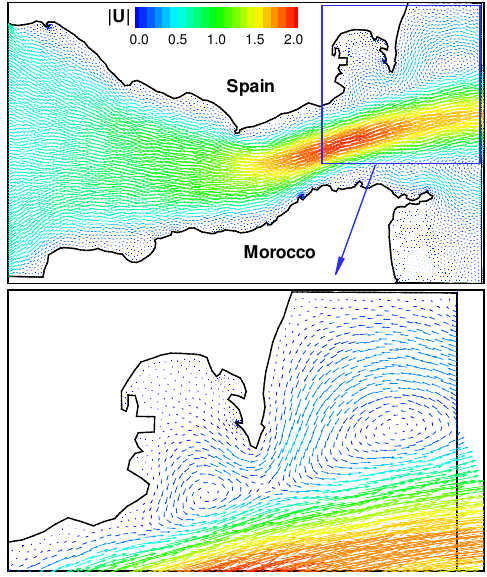
Figure 8. Velocity field of the flow in the Strait of Gibraltar.